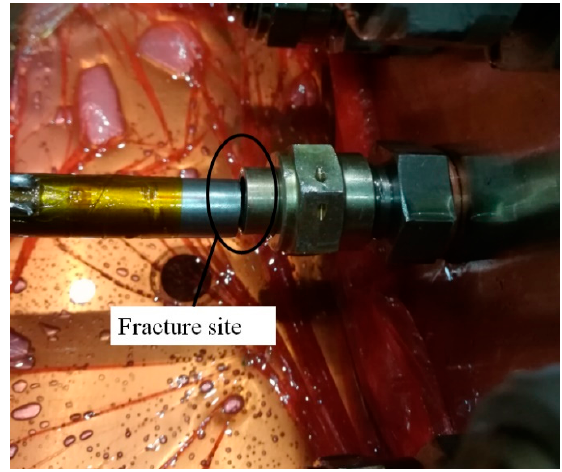
Figure 2. Fracture site.